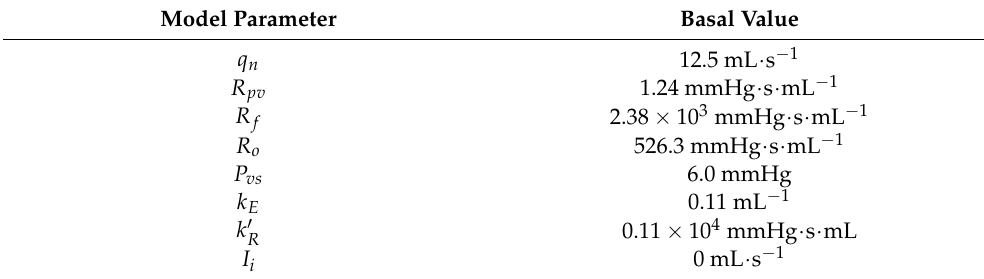
Table 1. Model parameters in basal